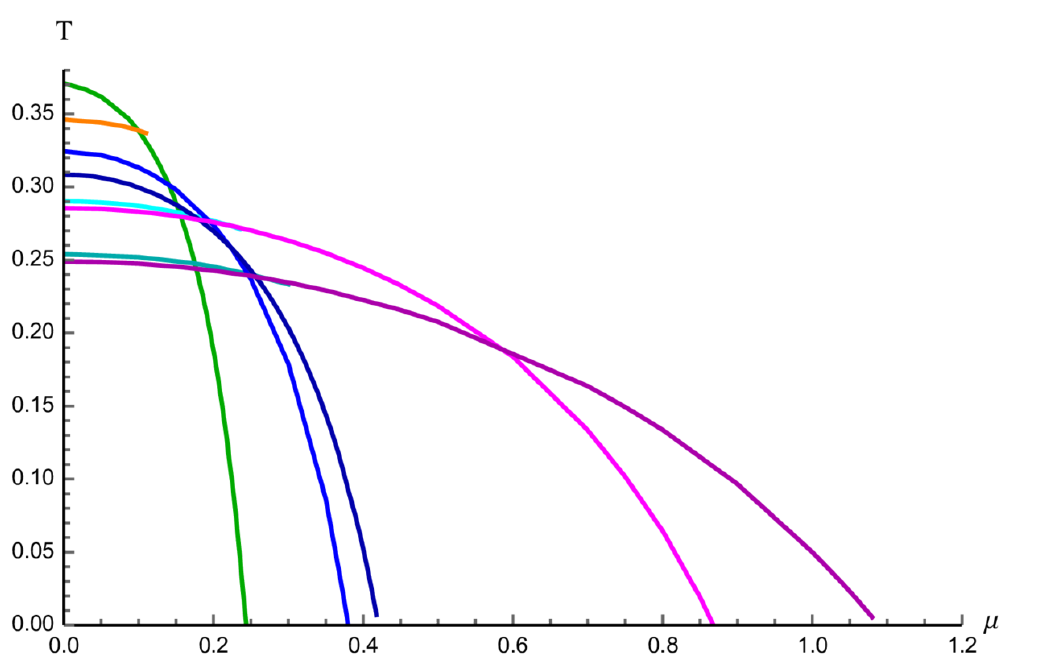
Figure 44 . Con(cid:12)nement-decon(cid:12)nement phase transitions of Wilson lines W iso for (cid:23) = 1 (green), W x and W y for (cid:23) = 2 (blue and magenta) and (cid:23) = 4 : 5 (dark blue and dark magenta); the background transition lines for (cid:23) = 1 (orange), (cid:23) = 2 (cyan) and (cid:23) = 4 : 5 (dark